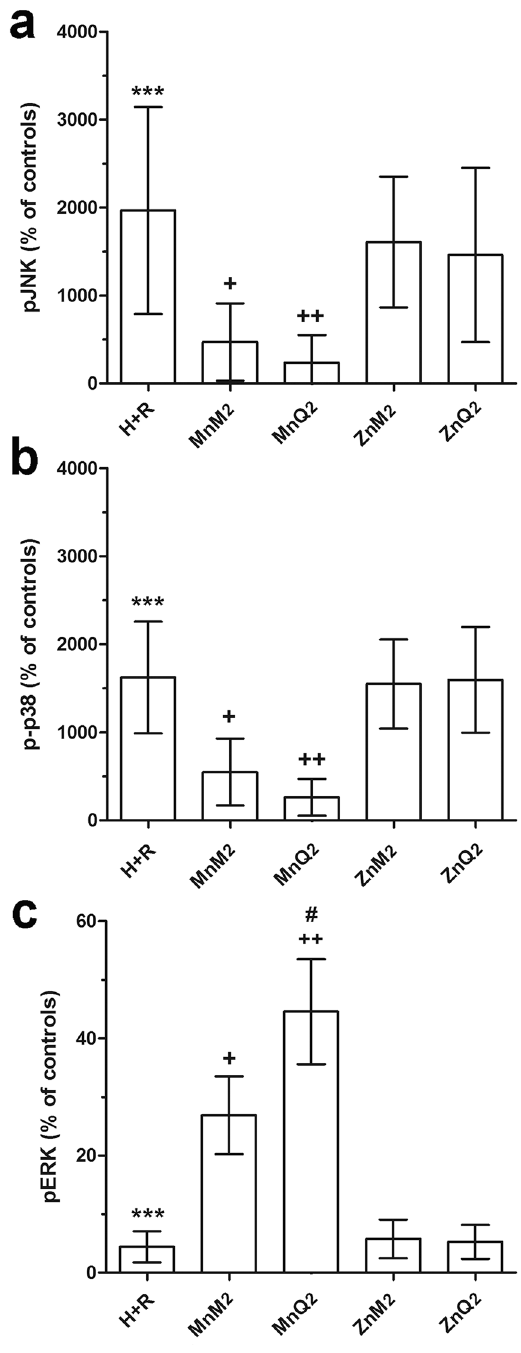
Figure 11. FACS analysis of immunofluorescent expression of phosphorylated (p − ) JNK ( a ) p38 ( b ) and ERK1/2 ( c ), evaluated at 1 h and expressed as percent changes of the untreated controls. The oxidative stress- related MAPKs p-JNK and p-p38 were increased by H + R and significantly decreased by MnQ2 and MnM2. Conversely, the cytoprotective pERK was decreased by H + R and significantly increased by MnQ2 and MnM2, the former compound being significantly more effective than MnM2. *** p < 0.001 vs. controls; + p < 0.05, ++ p < 0.01 vs. H + R; (one-way ANOVA); # p < 0.05 vs. MnM2 (Student’s t